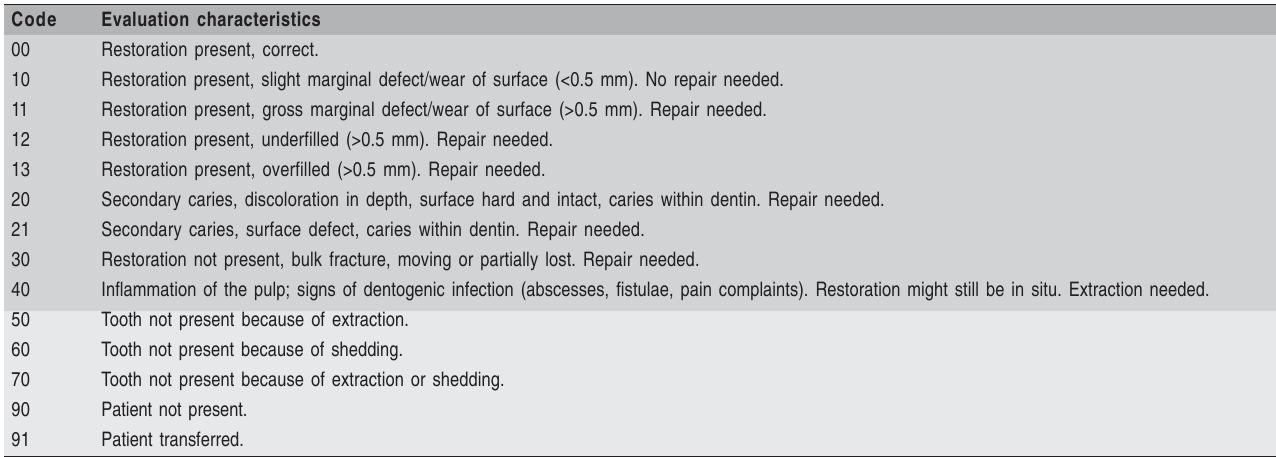
Table 2: Evaluation criteria for the ART restorations